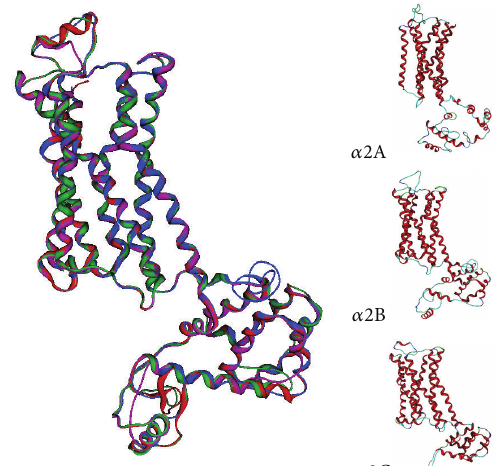
Figure 3: The homology models of three 𝛼 2 subtypes. The left is the template superposed by the three homology models, 2RH1: red, 𝛼 2A: green, 𝛼 2B: blue, and 𝛼 2C: